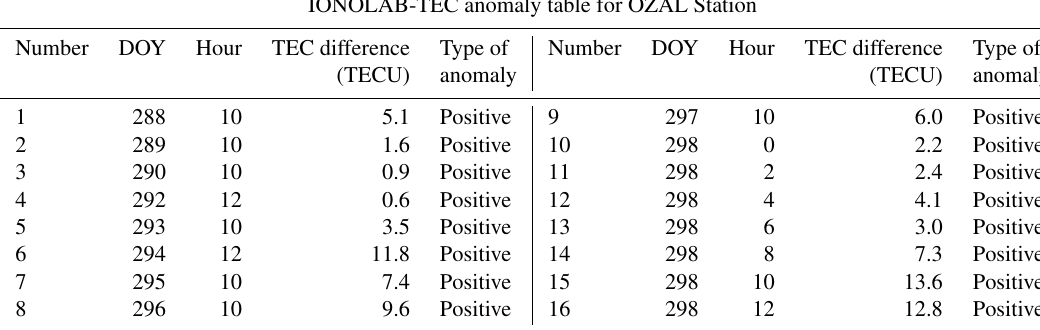
Table 2. OZAL Station IONOLAB-TEC anomaly table. IONOLAB-TEC anomaly table for OZAL Station